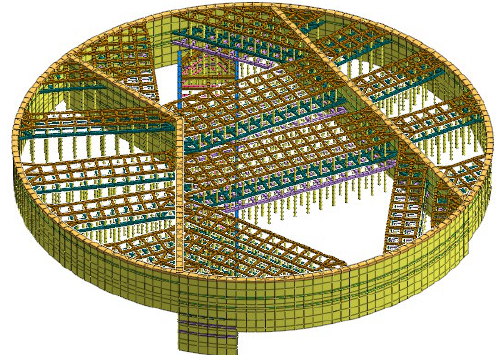
Figure 6. The model grid of the supporting structure.